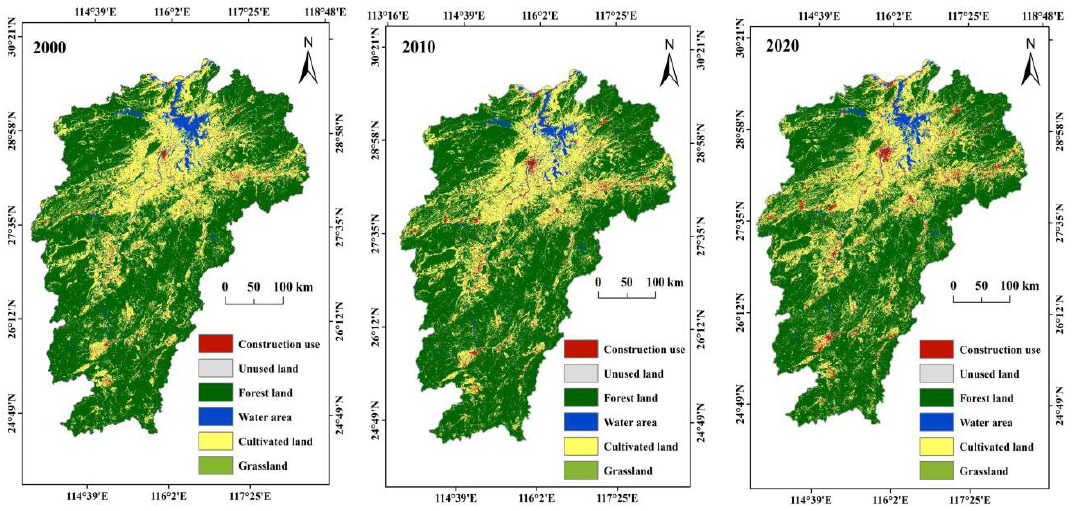
Figure 3. Spatial distribution of land use in Jiangxi Province, China during consecutive periods from 2000 to 2020 (represented by the starting year 2000, the middle year 2010, and the end year 2020).